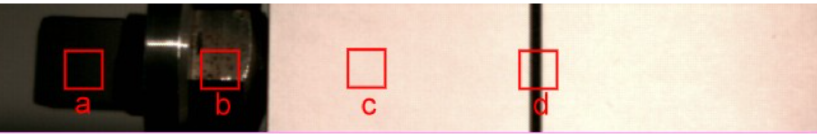
Figure 13. Result of combined communication signal and sensing [60].